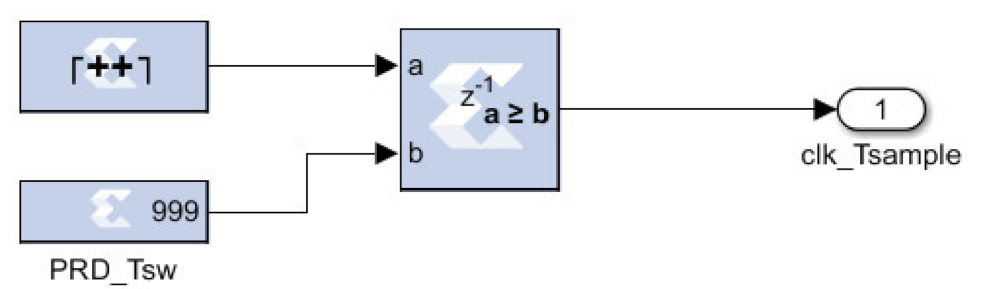
Figure 11. Block for sampling time (10 µ